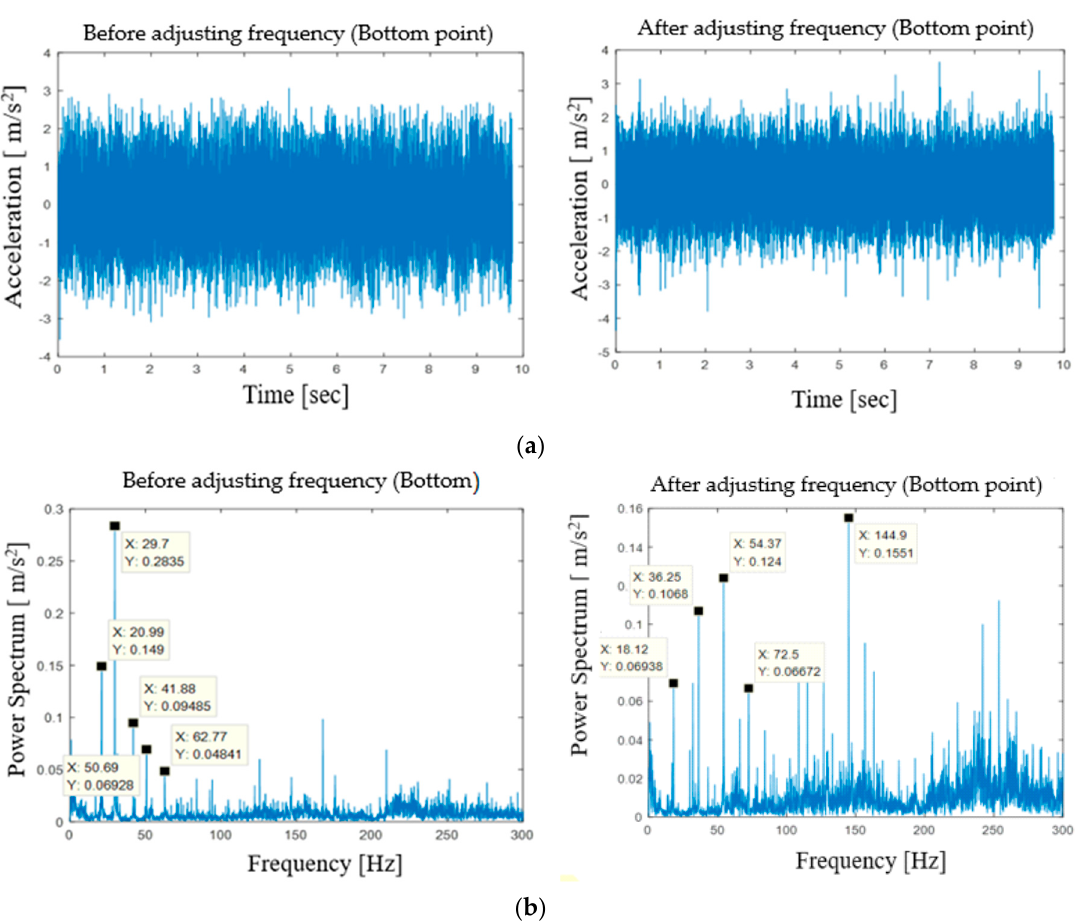
Figure9. Vibrationresponsesbeforeandafteradjustingdrivingfrequencyofthesandunits: ( a )Vibration response of the time domain at the bottom point of sand unit; ( b ) Vibration response of the frequency domain at the bottom point of the sand